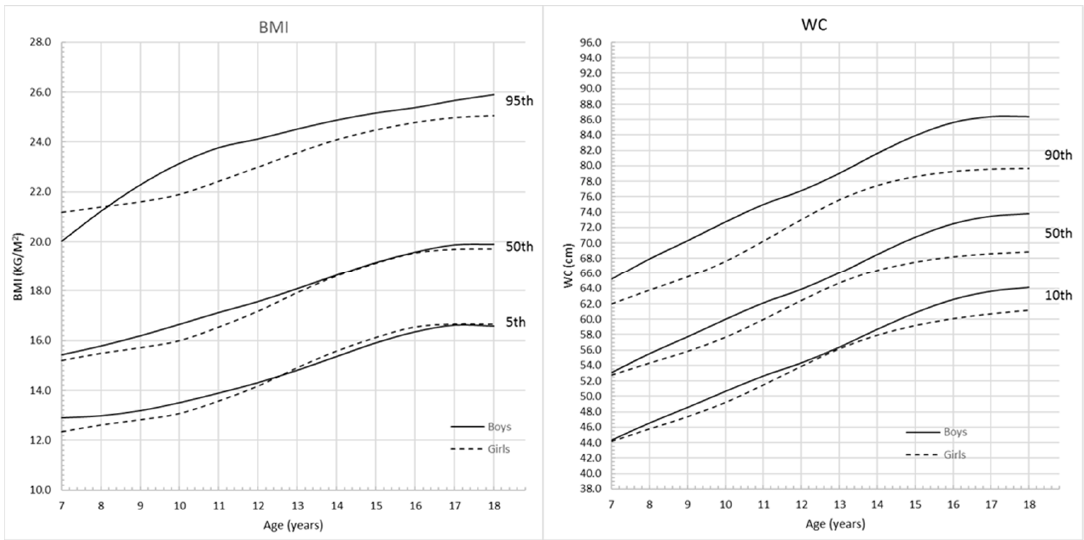
Figure 3. Comparison of the BMI and WC percentile curves for Chinese boys and girls aged 7–18 years.